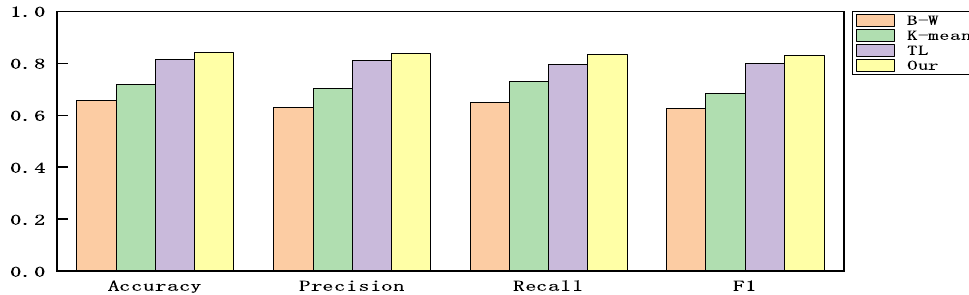
Figure 5. The results for DEFCON21.